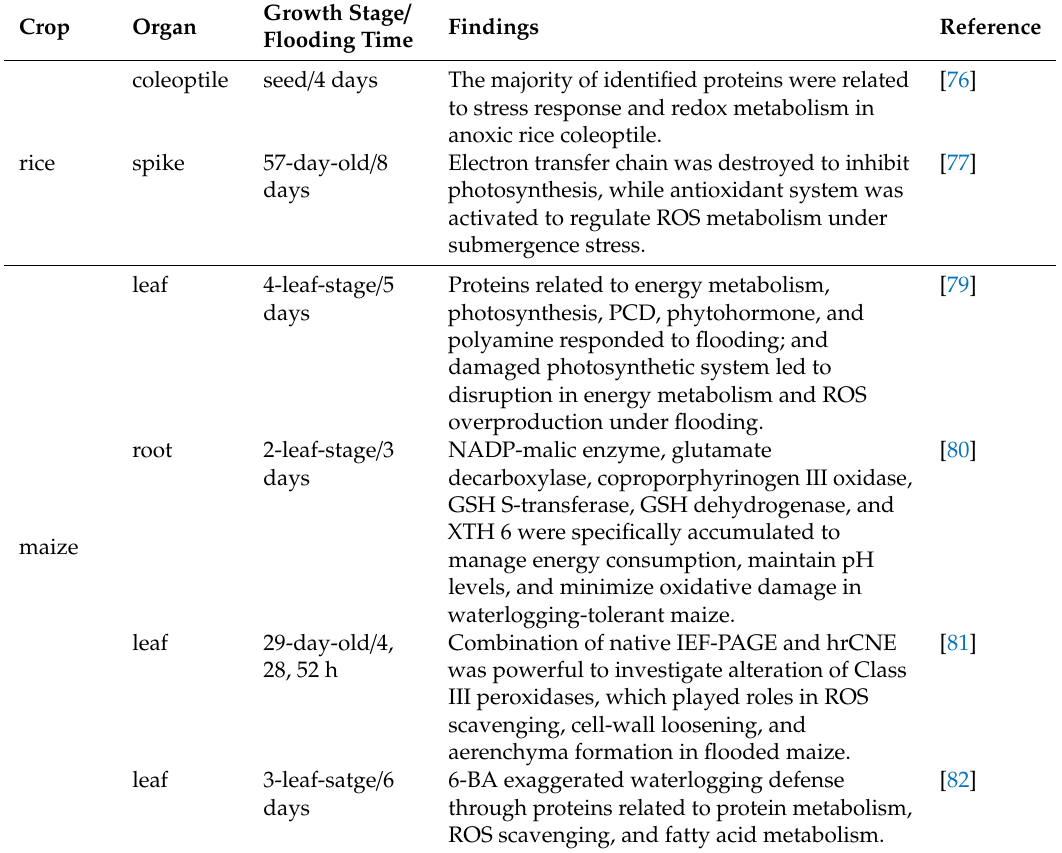
Table 1. Utilization of proteomics in other crops under flooding